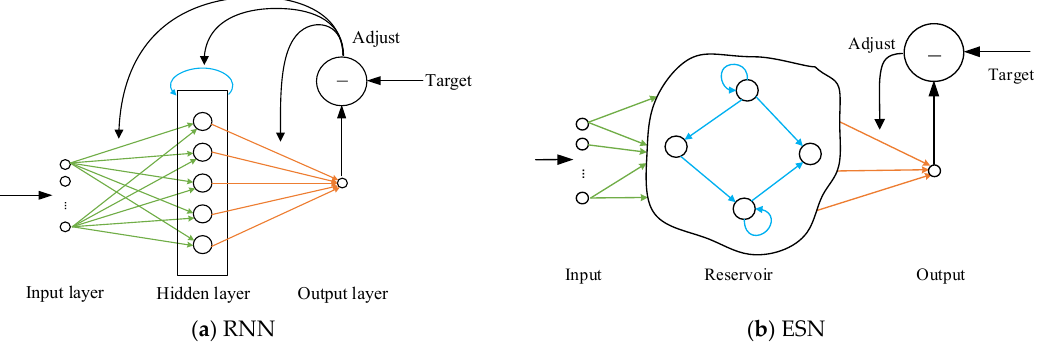
Figure 1. Schematic diagram of RNN and ESN. ( a ) In traditional RNN training, all connection weights including input ‐ to ‐ hidden (green arrows), hidden ‐ internal (blue arrows), and hidden ‐ to ‐ output (orange arrows) weights are adjusted. ( b ) In ESN, only the reservoir ‐ to ‐ output (orange arrows) weights are adapted.